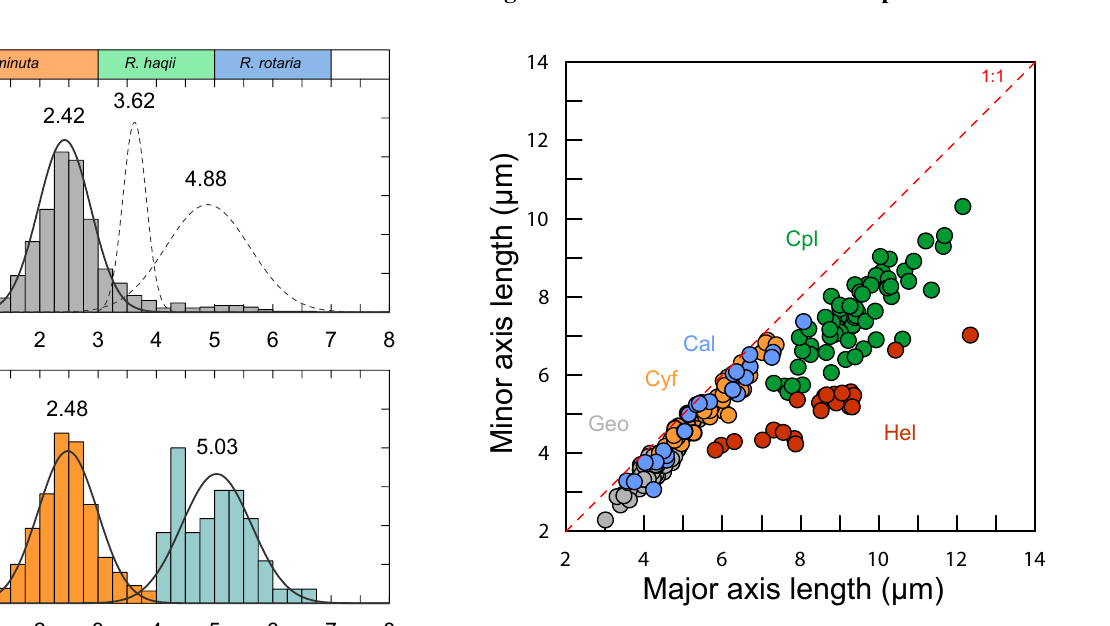
Figure C3. The short axis and long axis length distribution of coc- coliths in Fig.